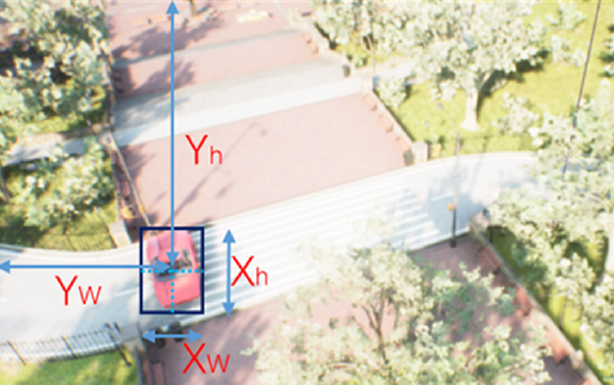
Figure 4. Location and size information of the recognition box obtained by the YOLOv5 algorithm. X h , X w represent the size of the object in the image, and Y w , Y h represent the position of the object center in the image. They are normalized values, which are obtained by taking the number of target pixels divided by the height or width of the image.